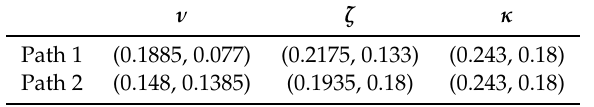
Table 2. Two-coin example with Q = 50.